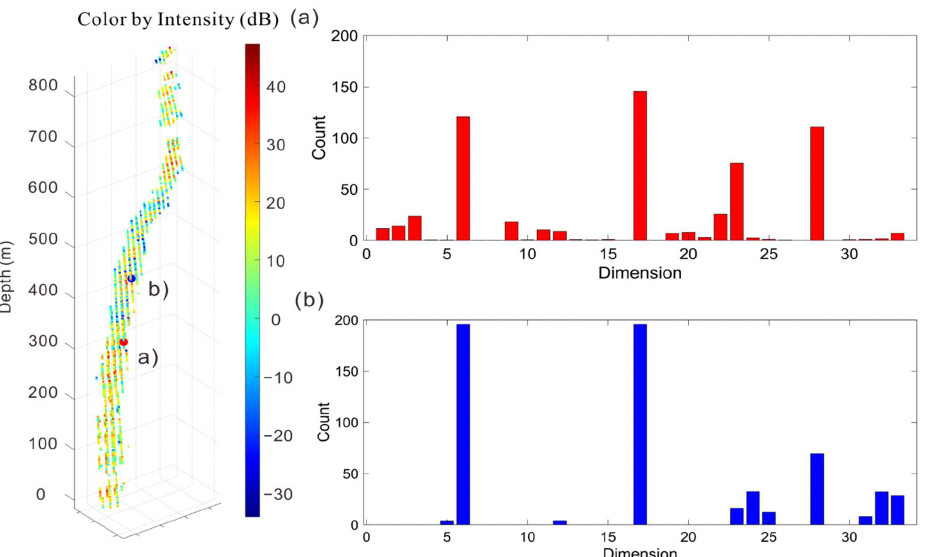
Figure 10. FPFH feature histogram of the plume model point cloud key point ( a , b ). The spatial lo- cation of the key points of the selected plume model is shown in the left panel, and the FPFH histo- grams of key points a and b are shown in the right panel, respectively. It can be seen that the histo- gram shows that the two feature point feature histograms are extremely similar, and that 6, 17, and 28 have unusually high dimensional values, which play an important role in the subsequent feature detection of the point cloud model. FPFH is used to identify the matching features between point clouds, and the key points of the model and candidate point clouds are detected for features by setting the spatial relation threshold and matching threshold to determine whether they are target point clouds [53]. The thresholds defined for feature matching are as follows: The matching threshold consists of scalars in the range [0, 1]. Two feature vectors are matched when the normalized Euclidean distance is less than or equal to the matching threshold. The spatial relation threshold, on the other hand, uses point cloud data to esti- mate the spatial relationship between points associated with potential feature matches, and finds potential matches based on the spatial relationship threshold. For FPFH feature matching, the normalized Euclidean distance matching feature is calculated based on the found matching points, the algorithm initialization detection threshold is set to 0.1, and the scores are returned as a column vector to evaluate the de- gree of matching, where a smaller value indicates a higher probability that the point cloud to be detected is a plume. The threshold is adjusted to the optimal matching state in the experiment and determines the threshold, as shown in Figure 11. The scores are averaged to determine whether the cloud at the detection point is a plume.